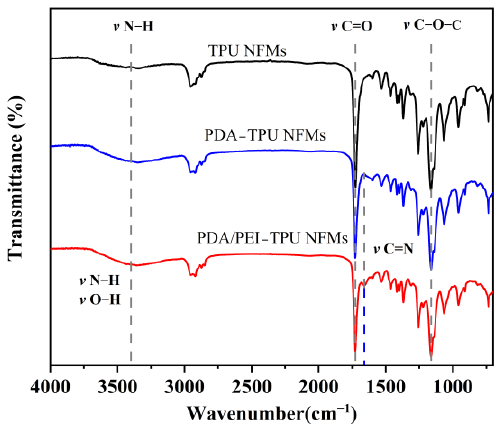
Figure 4. ATR-FTIR spectra of the TPU NFMs, PDA-TPU NFMs and PDA/PEI-TPU NFMs.